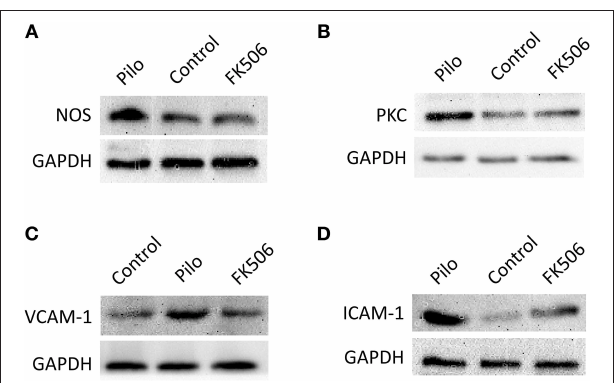
FIGURE 5 | The protein expression of VCAM-1, ICAM-1, PKC δ , and TNF in the hippocampus of different treatment groups. (A) Protein expression of NOS in the control group, epilepsy group, and FK506 group after 6h of modeling. (B) Protein expression of PKC δ in the control group, epilepsy group, and FK506 group after 6h of modeling. (C) Protein expression of VCAM-1 in the control group, epilepsy group, and FK506 group after 24h of modeling. (D) Protein expression of ICAM-1 in the control group, epilepsy group, and FK506 group after 24h of modeling. The internal reference was glyceraldehyde-3-phosphate dehydrogenase